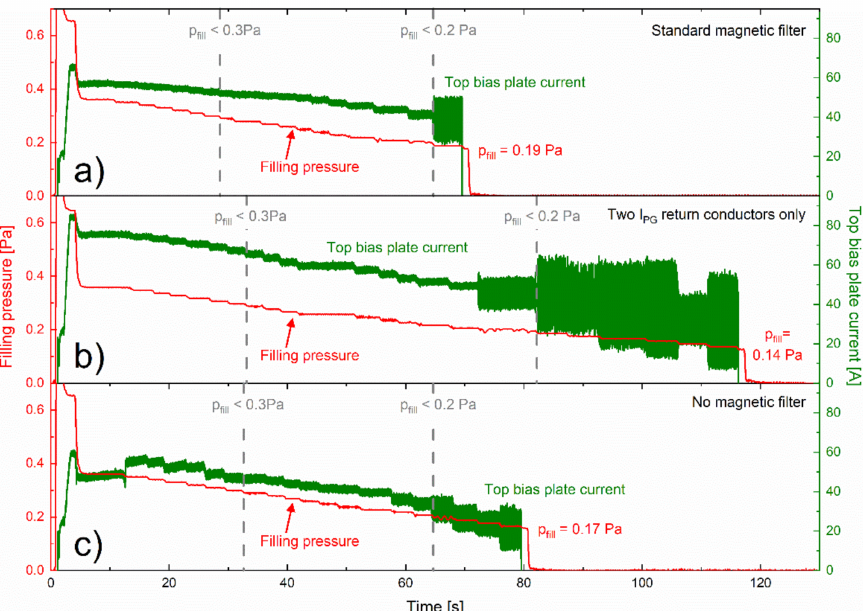
Figure 4. Time traces of the filling pressure and the current flowing onto the top segment of the bias plate when approaching in deuterium the low-pressure operational limit for three different magnetic filter topologies: ( a ) the standard setup, ( b ) using two I PG return conductors only and ( c ) without a magnetic